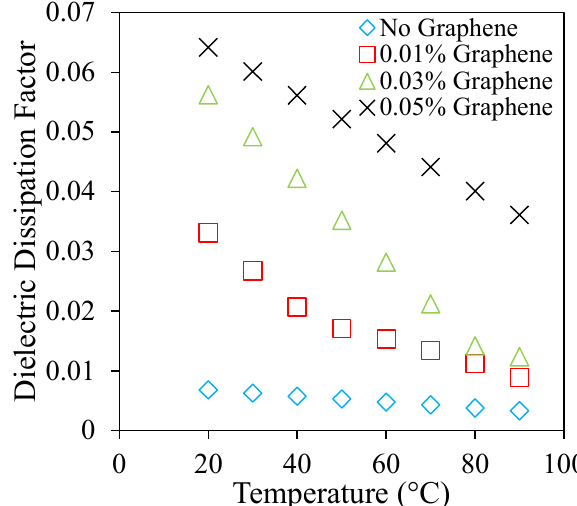
Figure 8. Variation of dielectric dissipation factor of graphene–transformer oil nanofluid with